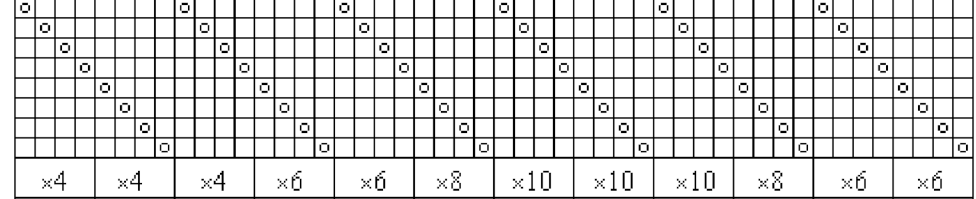
Figure 1. Drawing-in scheme of woven